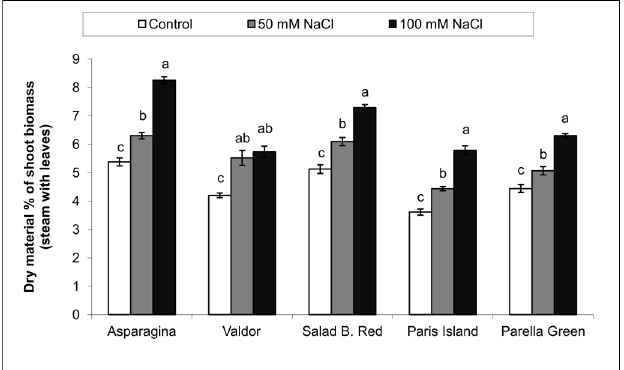
Fig. 2: Percentage of dry matter in the biomass of leaves of five lettuce cultivars developed under different salinity levels in the nutrient me- dium. Vertical bars represent ± SE from means (n = 5). Different letters indicate significant differences among treatments of the same cultivar, at P < 0.05.